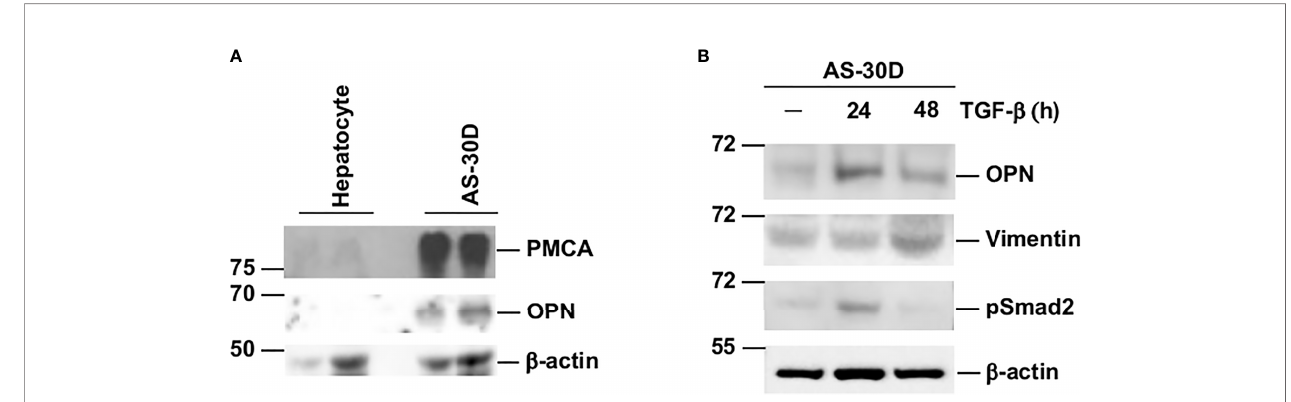
FIGURE 7 | AS-30D cells express high protein levels of PMCA and OPN and increase the expression of mesenchymal markers after TGF- b stimulation. (A) Protein levels for PMCA and OPN in hepatocytes and AS-30D cells were detected by Western blot. One hundred micrograms of protein ( fi rst lane) and 200 m g (second lane) were run for each cell type. (B) AS-30D cells were treated with 2 ng/ml of TGF- b for 24 and 48 h OPN, vimentin, and phospho-Smad2 protein levels were detected by Western blot. One hundred micrograms of protein were run in each lane. b -Actin was used as a loading control.